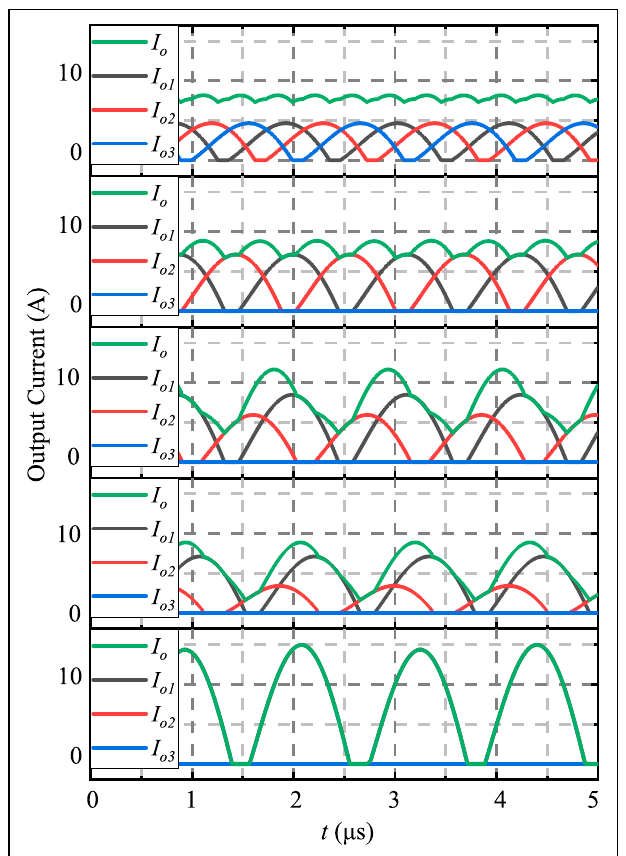
FIGURE 8 | The output currents under different load distribution schemes with 120-W output power in simulation.